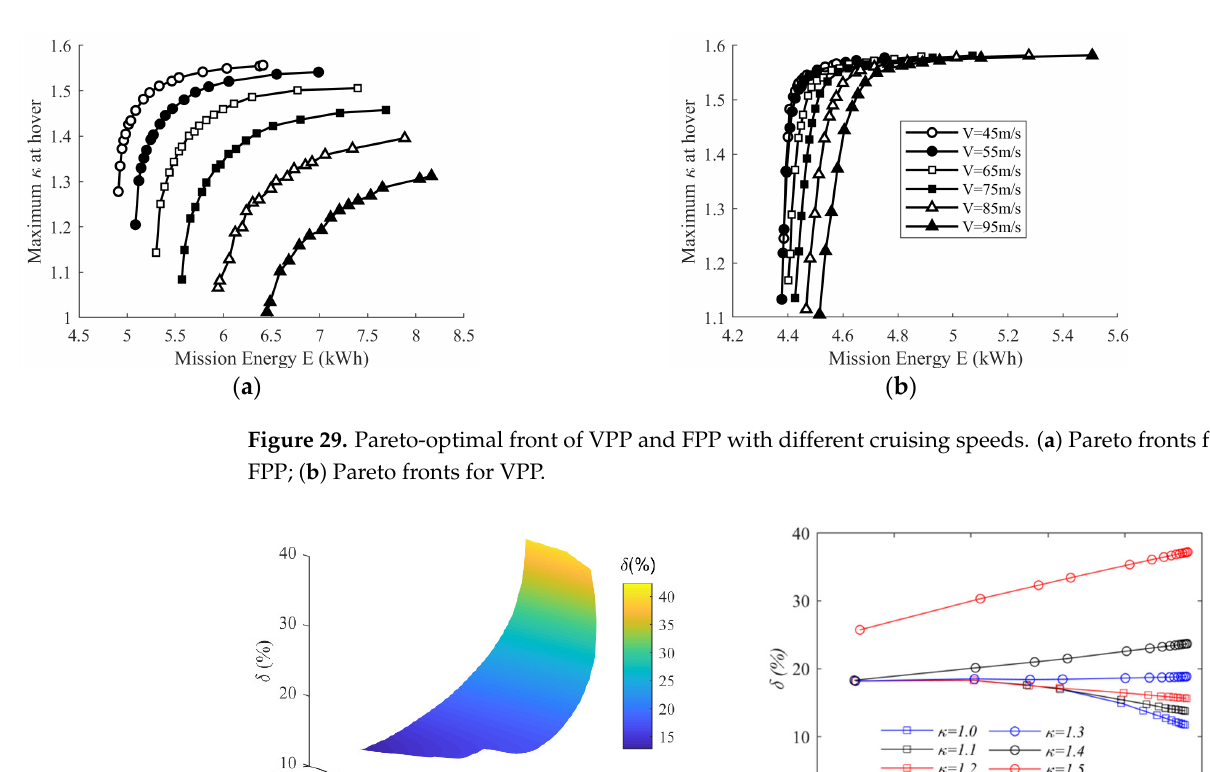
Figure 29. Pareto-optimal front of VPP and FPP with different cruising speeds. ( a ) Pareto fronts for FPP; ( b ) Pareto fronts for VPP.